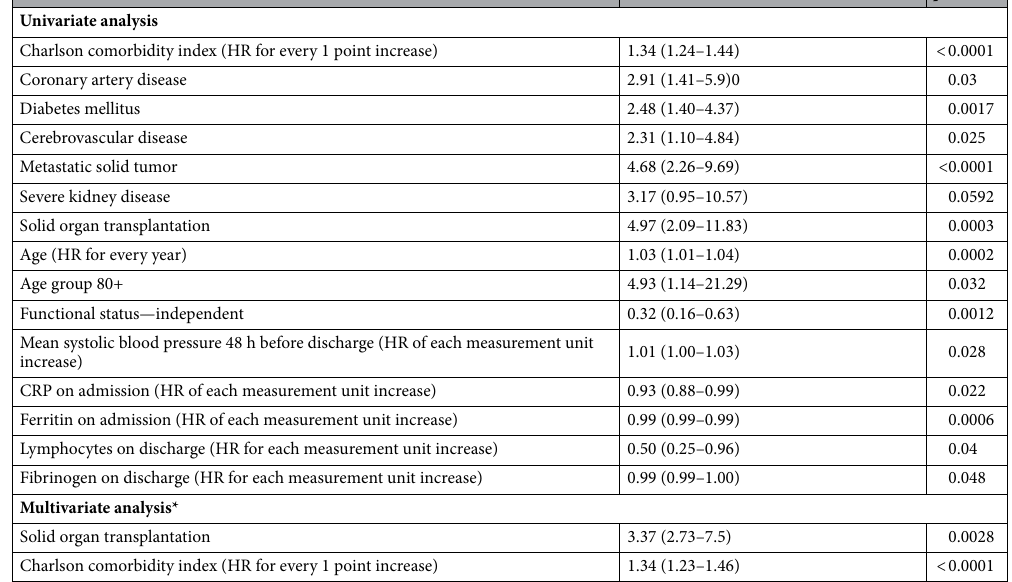
Table 3. Factors associated with re-admission. *Multivariate analysis included age, gender, admission length of stay, CCI and solid organ